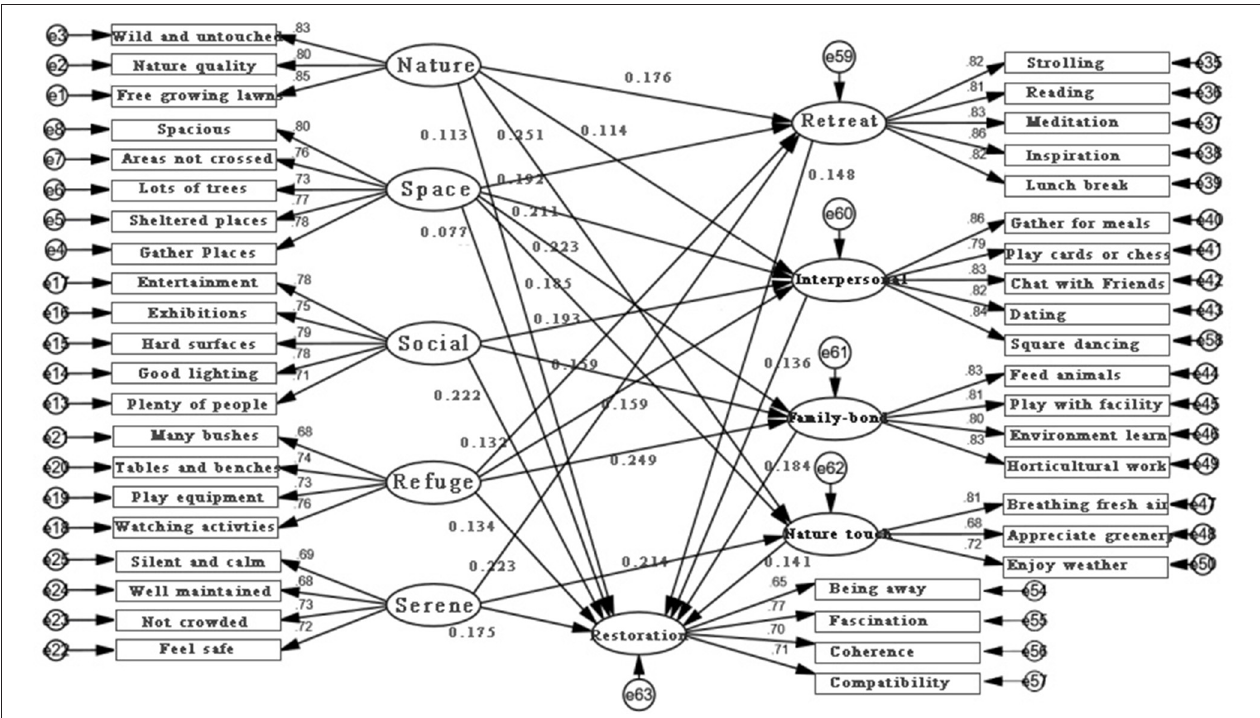
FIGURE 2 | Final result of structural equation modeling analysis.